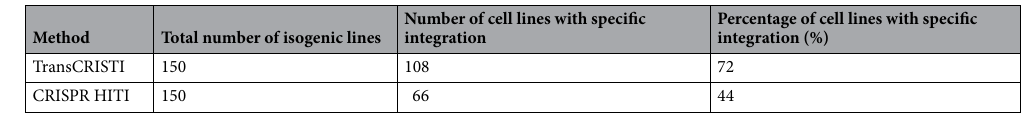
Figure 2. Intron-based gene knock-in mediated by TransCRISTI. ( A ) Schematic illustration of the gene- trap knock-in method by TransCRISTI in the human AAVS1 gene (ACNO. S51329). HEK293T cells were cotransfected with a plasmid encoding Cas9.PB dm effector and sgRNA #2 (pHX_5004) and a gene-trap donor construct (pHDS_600) (Table S1). Donor plasmid contains a splice acceptor site (SA), a sequence encoding T2A self-cleaving peptide, EGFP gene, and polyA signal flanked by piggyBac 5 ′ ITR and 3 ′ ITR. The transposon fragment integrates into the sgRNA binding site #2 (sgBS #2) in the first intron of the AAVS1 gene. In the transcript produced under the control of endogenous AAVS1 promoter, the SA sequence promotes the attachment of the T2A to the exon1 of AAVS1 and splicing out of 5 ′ ITR, leading to a mature transcript that can be translated to EGFP protein. ( B ) The left panel is the fluorescent image of EGFP expressing cells, 48 h post-transfection. The EGFP expressing cells were considered positive for the intron-based insertion of the promoterless construct into the sgBS #2 sequence (left panel). The right panel is a merged image of brightfield and fluorescent. The scale bar indicates a length of 100 μm. ( C ) EGFP-expressing cells were counted in each experimental group. Group 1 (TransCRISRTI group) cells were transfected with plasmids encoding Cas9.PB dm , sgRNA #2, and a plasmid containing the transposon. The plasmid components are shown for four control groups (C1, C2, C3, and C4). Results are represented as the percentages of the EGFP positive cells over the total transfected cells. The statistical differences between the TransCRISRTI group and the control groups were analyzed by the Mann–Whitney U test. * p < 0.001. ( D ) Gel electrophoresis of PCR fragments to confirm the specific knock-in event at the first intron of the AAVS1 locus. F3 primer located on the first intron of AAVS1 and R4 primer on 5 ′ ITR in the donor construct (Tables S1, S2) were used to amplify a 509 bp product (lane 1) in the PCR reaction of genomic DNA of cells with specific insertion. Lane M is a 1 Kb DNA size marker. ( E ) TIDE analysis shows the indel spectrum of the AAVS1 locus after targeting with Cas9 plus PB dm (left panel) and Cas9. PB dm (right panel). ( F ) Sanger sequencing analysis of the targeted region after Cas9.PB dm -mediated insertion of promoterless reporter showing two electropherogram traces.